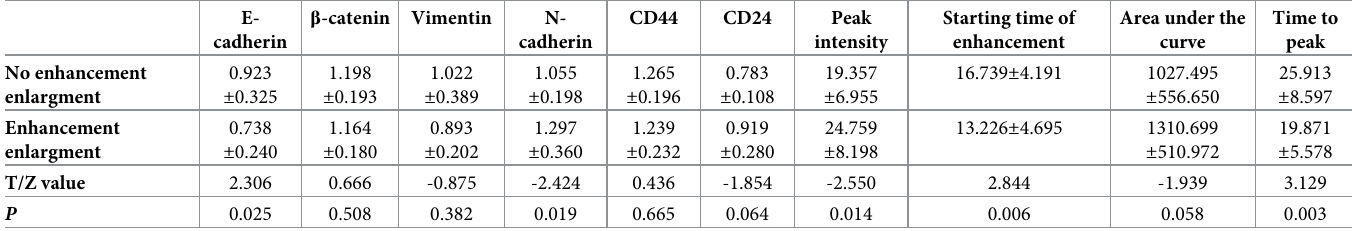
E- β -catenin Vimentin N- cadherin